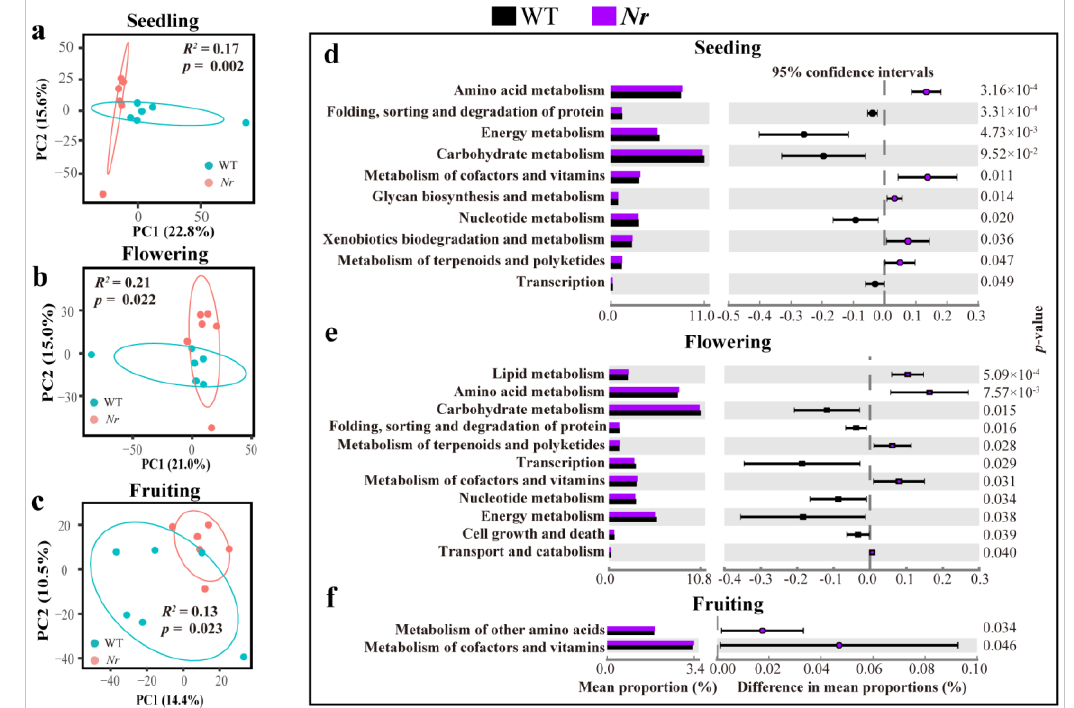
Figure 3. The functional potential of bacterial communities in the rhizosphere of WT and Nr plants. Principal component analysis (PCA) based on functional annotations of the rhizosphere bacterial community of WT and Nr plants at the seedling ( a ), flowering ( b ), and fruiting ( c ) stages. The functional KEGG level 2 pathway annotation was used for the comparison between WT and Nr plants at the seedling ( d ), flowering ( e ), and fruiting ( f ) stages. p-values are shown as inset panels based on two-sided Welch’s t -test.